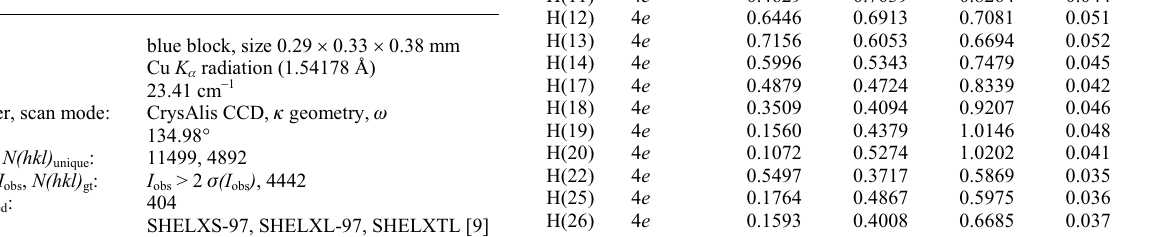
Table 1. Data collection and